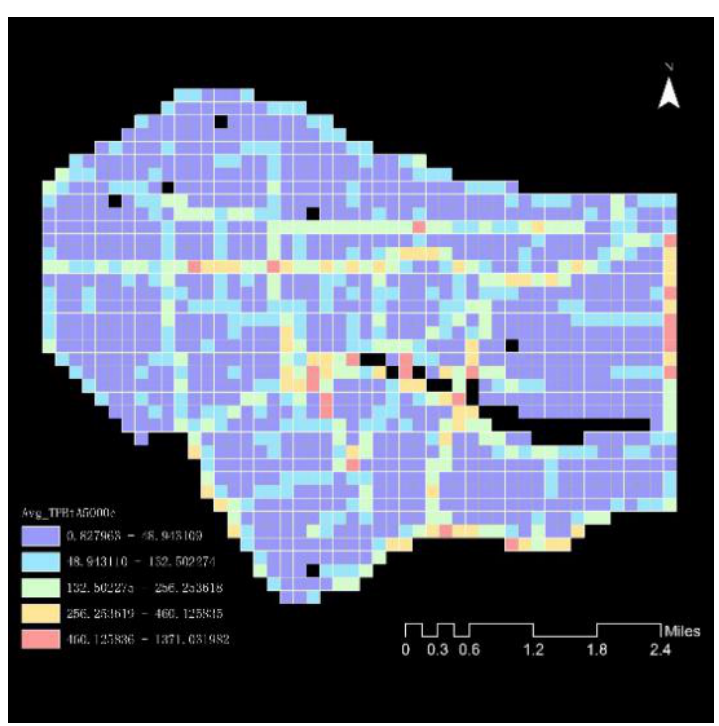
Fig. 22 Fishing net graph of regional TPBt at a radius of